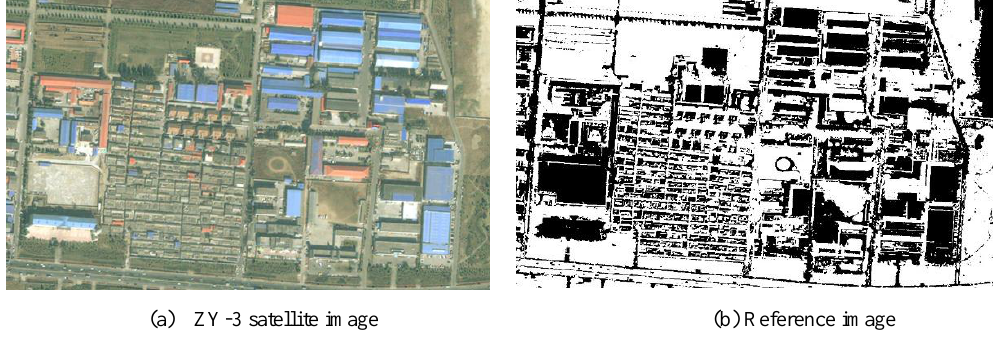
Figure 5. Analog image and reference image